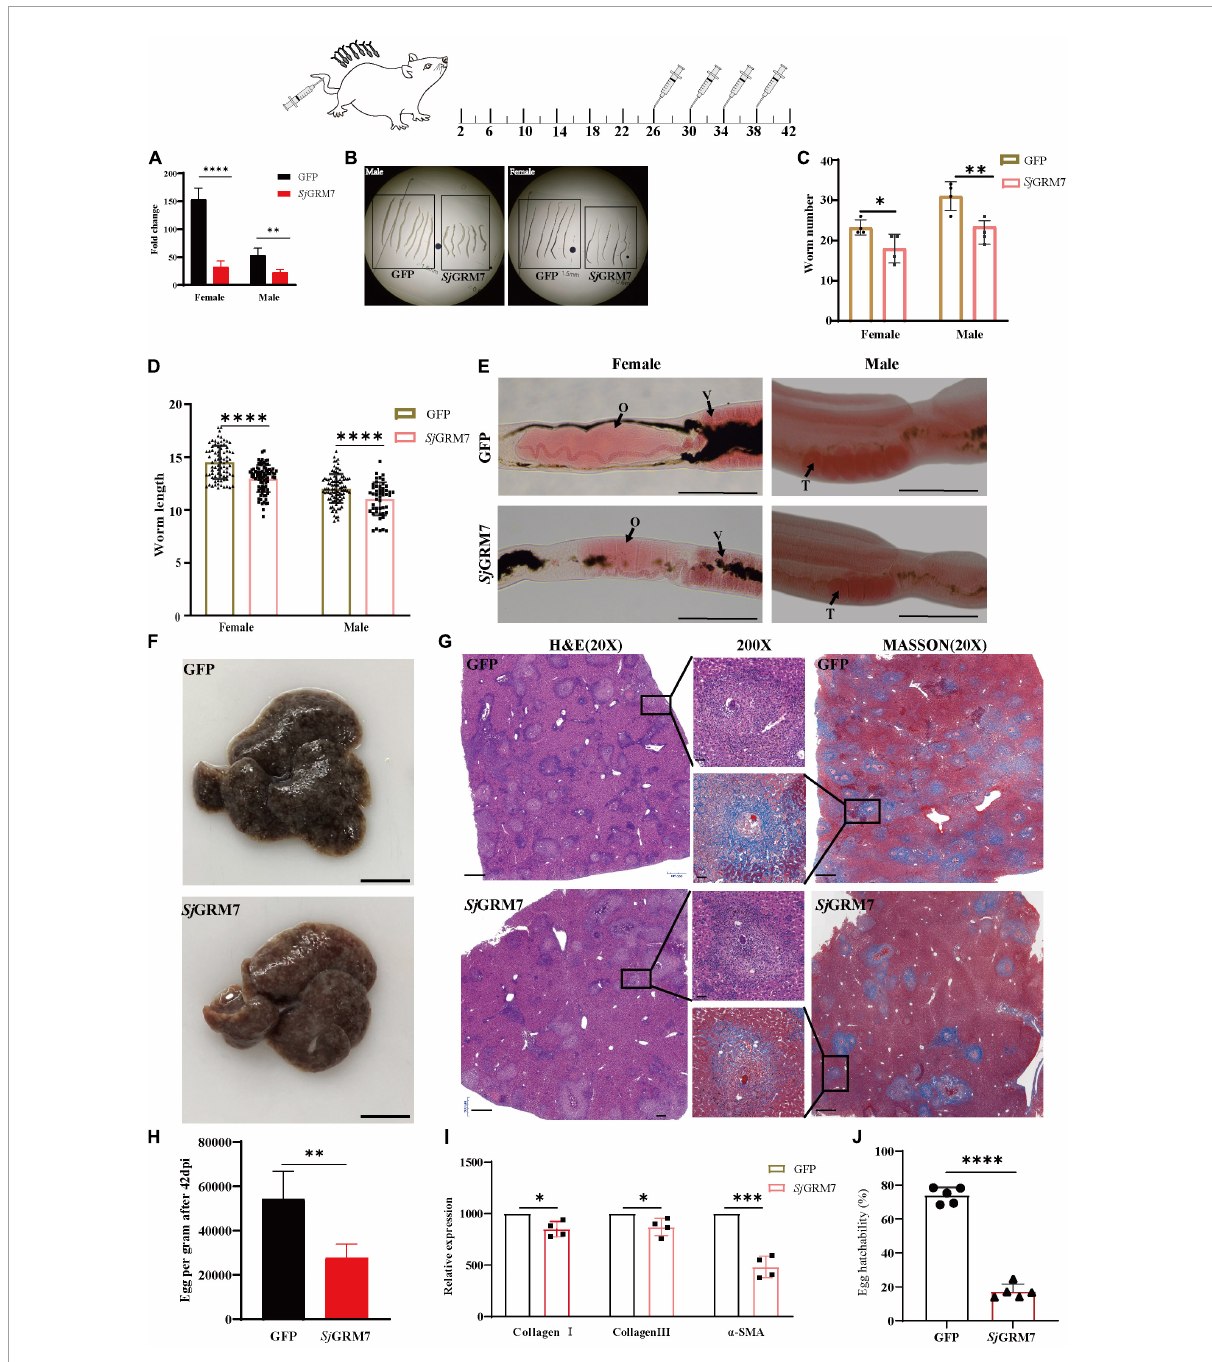
FIGURE5 Sj GRM7 affects oviposition in S. japonicum and alleviates host pathology in vivo. On the 26th, 30th, 34th, and 38th days after abdominal patch infection, dsRNA was injected through the tail vein, and the hepatic portal vein was perfused on the 42nd day. (A) Sj GRM7 transcript relative mRNA levels in the Sj GRM7 dsRNA group. (B) Morphological changes in worms collected at 42 dpi. (C) Comparison of worm numbers between GFP and Sj GRM7 dsRNA groups. (D) Comparison of worm length between the GFP and Sj GRM7 dsRNA groups. (E) Morphological changes in the gonads of female and male worms were observed by carmine staining. (F) Gross observations of the mouse liver in the GFP and Sj GRM7 dsRNA groups. (G) Liver sections stained with hematoxylin and eosin (H&E) (left) showing egg granulomatous lesions; Masson’s trichrome staining (right); liver fibrosis, granuloma formation, and liver fibrosis from individual eggs were also observed (middle). (H) Eggs per gram comparison between the GFP control and Sj GRM7 dsRNA groups. (I) qPCR showed that the mRNA levels of collagen I, collagen III, and α -SMA in the Sj GRM7 dsRNA group were significantly lower than those in the GFP control group. (J) Comparison of egg hatchability between GFP and Sj GRM7 dsRNA groups. O, oocytes; e, eggs; T, testis. E, 200 µ m; F, 10 mm.; G, left and right, 500 µ m; middle, 50 µ m; GFP, green fluorescent protein; dpi, days post infection; dsRNA, double-stranded RNA; GRM, metabotropic glutamate receptor; qPCR, quantitative polymerase chain reaction; α -SMA, α -smooth muscle actin protein ∗∗∗∗ P < 0.0001, *** P < 0.001, ∗∗ P < 0.01, ∗ P <